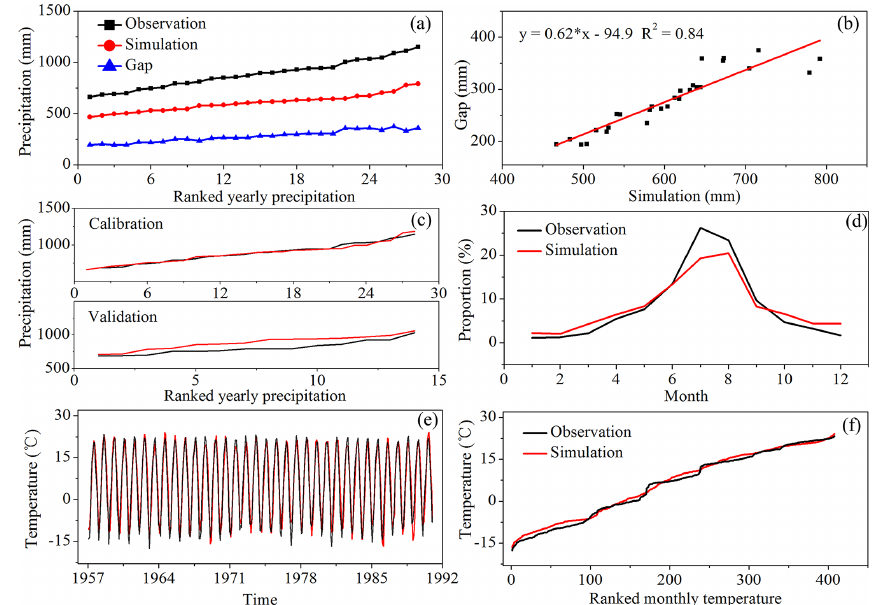
Figure 3. Correction of the simulated climate data from the ECHO-G model based on observations during 1957–1990: (a) annual ranked precipitation distribution of observations, simulations, and the gap; (b) the relationship between simulations and the gap during 1957–1970 and 1977–1990; (c) calibration (1957–1970 and 1977–1990) and validation results (1967–1980); (d) monthly measured and simulated rainfall percentage; (e, f) comparison of the simulated and observed temperatures during